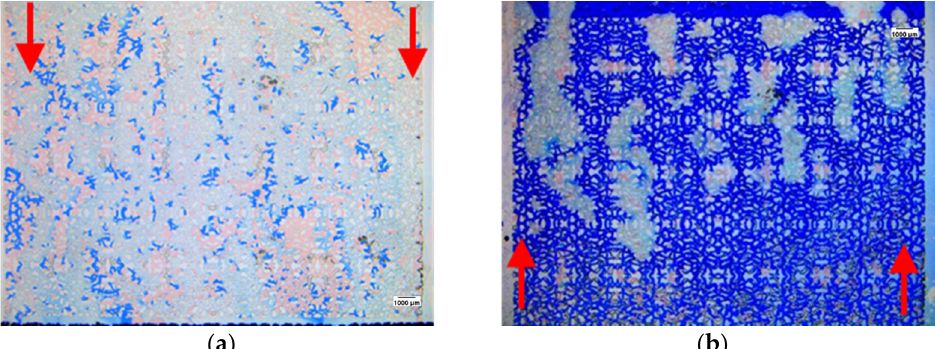
Figure 8. Emulsion water plugging mechanism diagram under the action of the emulsifier: ( a ) the schematic diagram of the emulsion water-plugging mechanism; ( b ) 0 s; ( c ) 100 s; ( d ) 200 s.